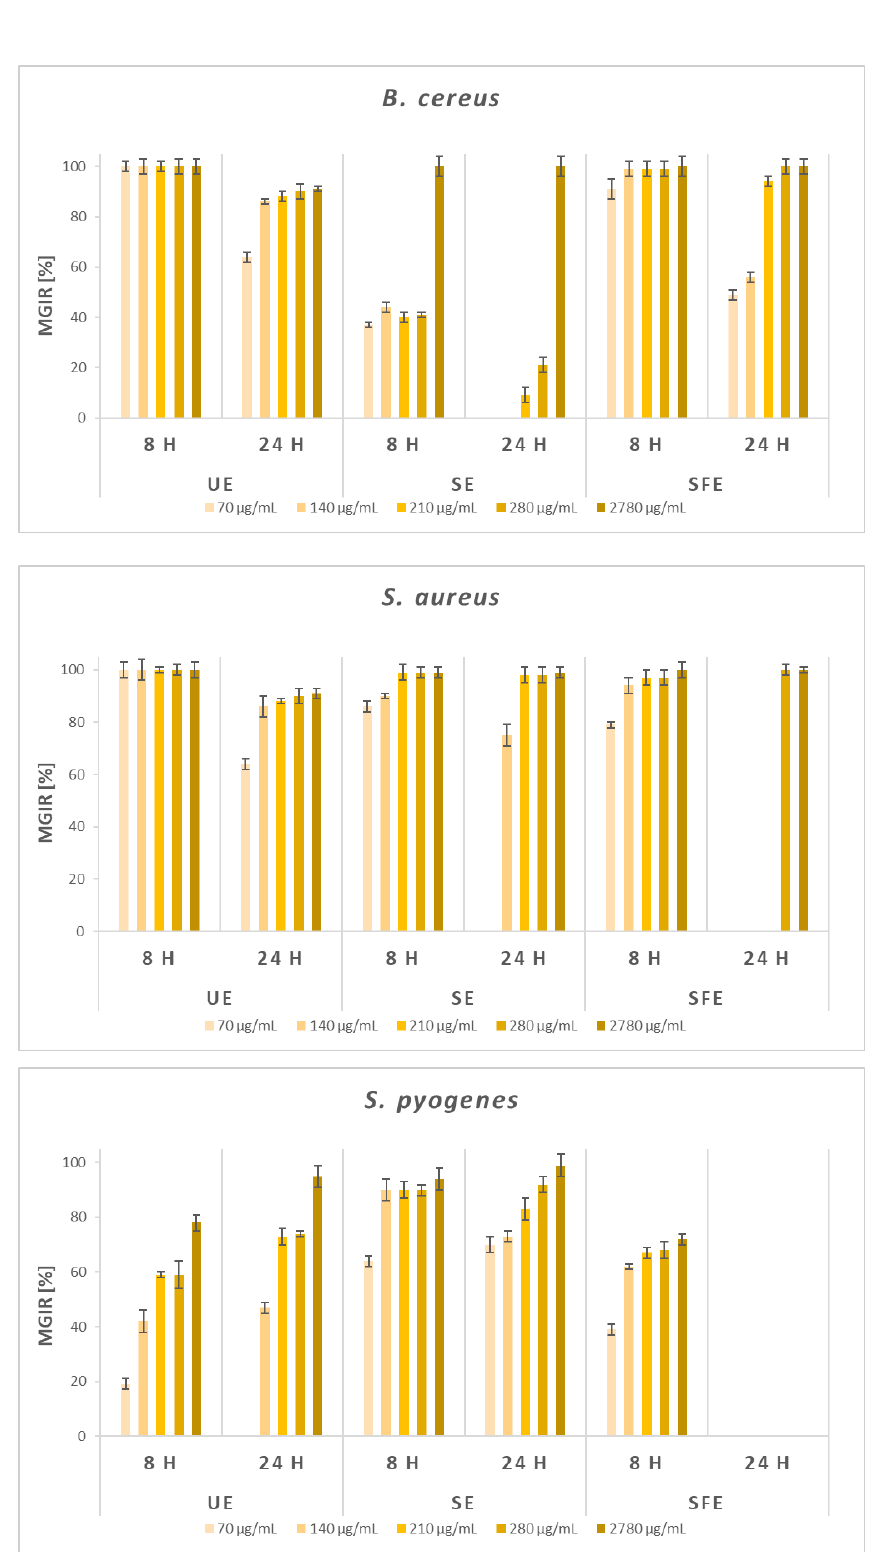
Figure 5. Microbial growth-inhibition rates (MGIRs) for AS extracts obtained by ultrasonic extraction (UE; solvent H 2 O), Soxhlet extraction (SE; solvent EtOH), and supercritical fluid extraction (SFE; solvent scCO 2 , co-solvent EtOH) using 70, 140, 210, 280, and 2780 µ g sample per mL of selected Gram-positive bacteria